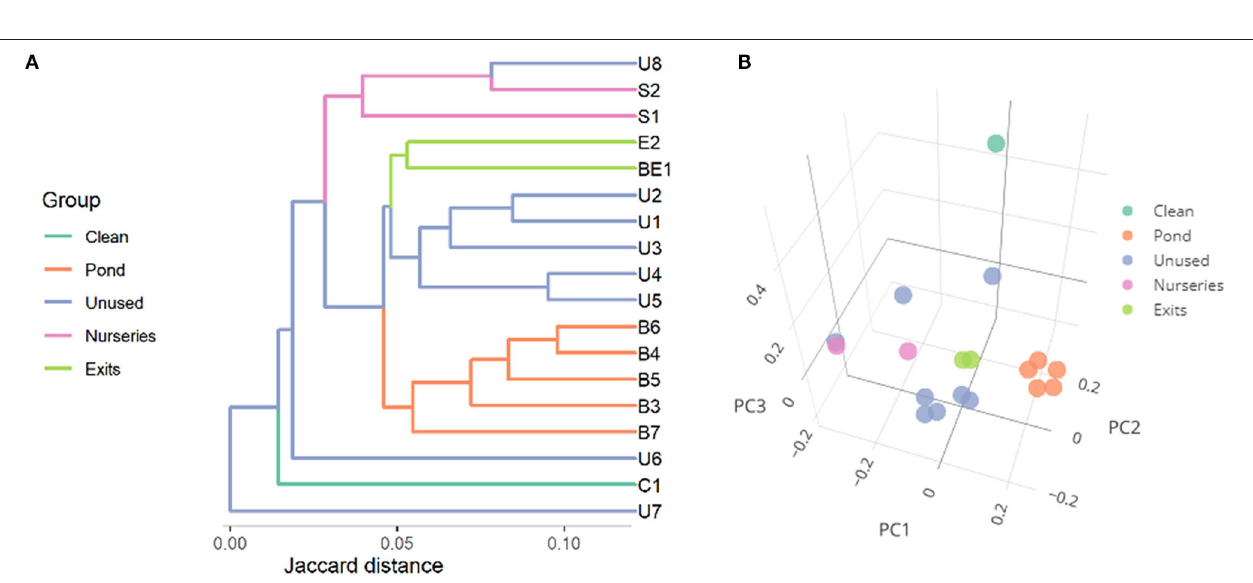
FIGURE 4 | Microbial similarity (beta-diversity) of specimens expressed as Jaccard distances and represented as (A) a dendrogram and (B) principal coordinates plot. The first three principal coordinates (PC) explain, respectively, 10.8, 8.4, and 7.1% of variance.